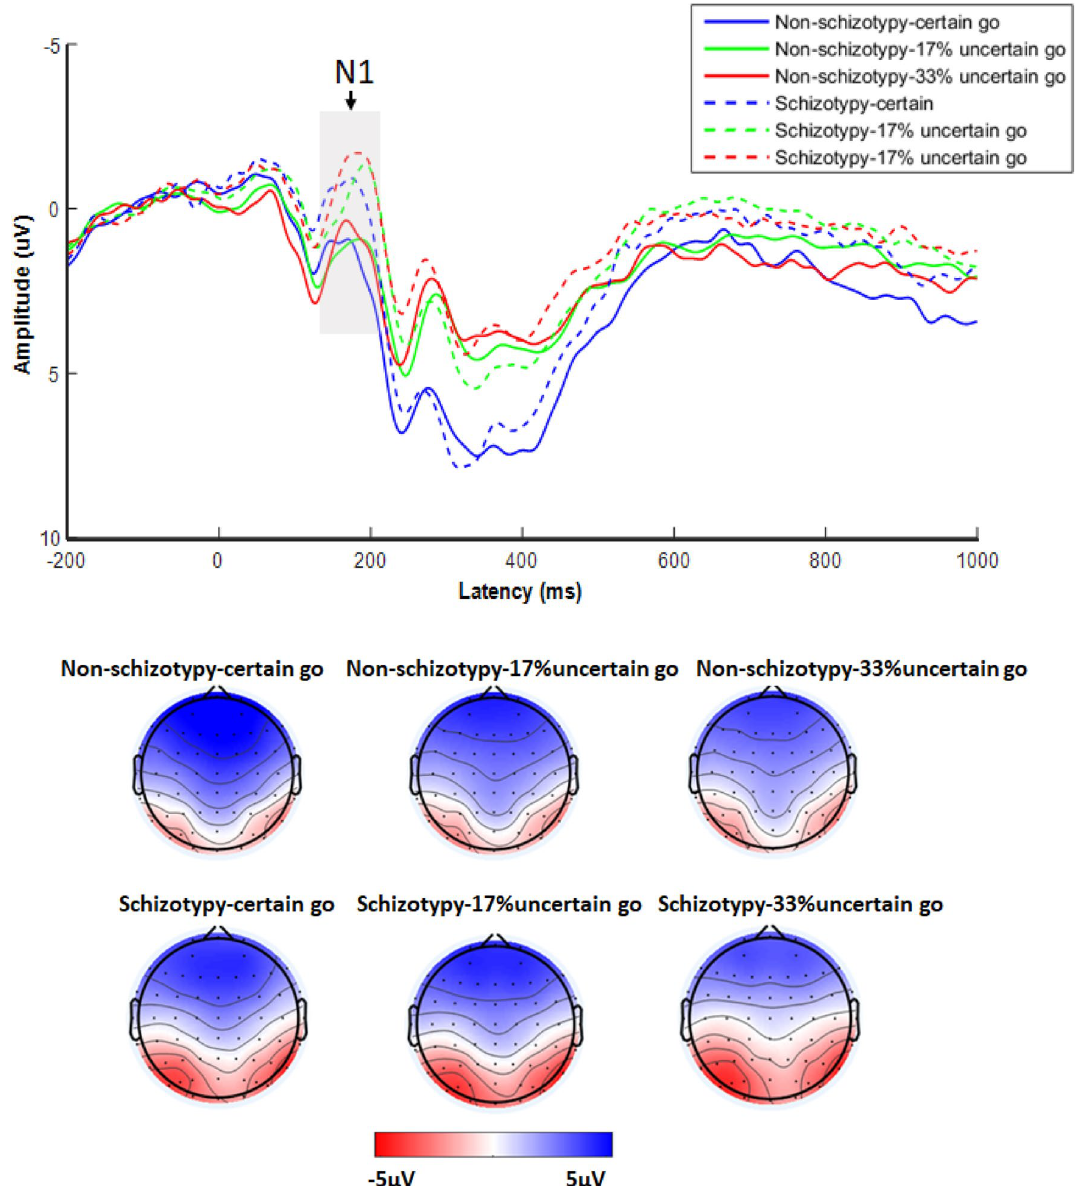
Figure 3. Grand-average event-related potentials (ERPs) elicited by different Go type at the Pz, P1, and P2 recording site for the non-schizotypy and schizotypy group. The gray-shaded areas indicate the 140- to 210-ms time window for the calculation of the mean value of the N1 wave. The time point “0” indicates stimuli